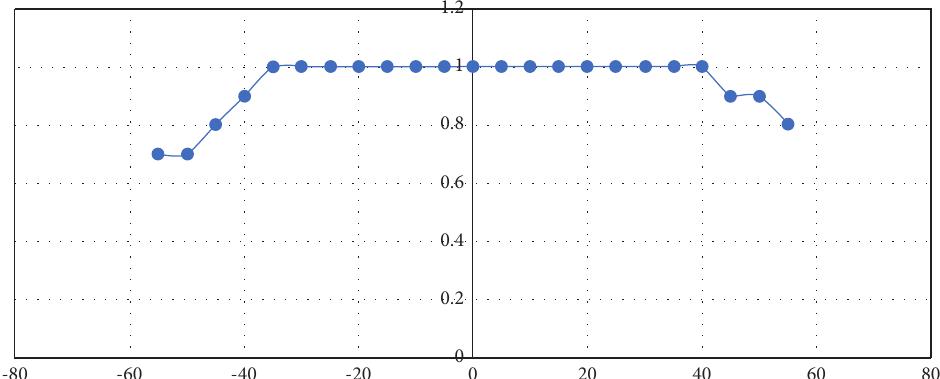
Figure 7: Relationship between the change in the brightness and the matching probability.